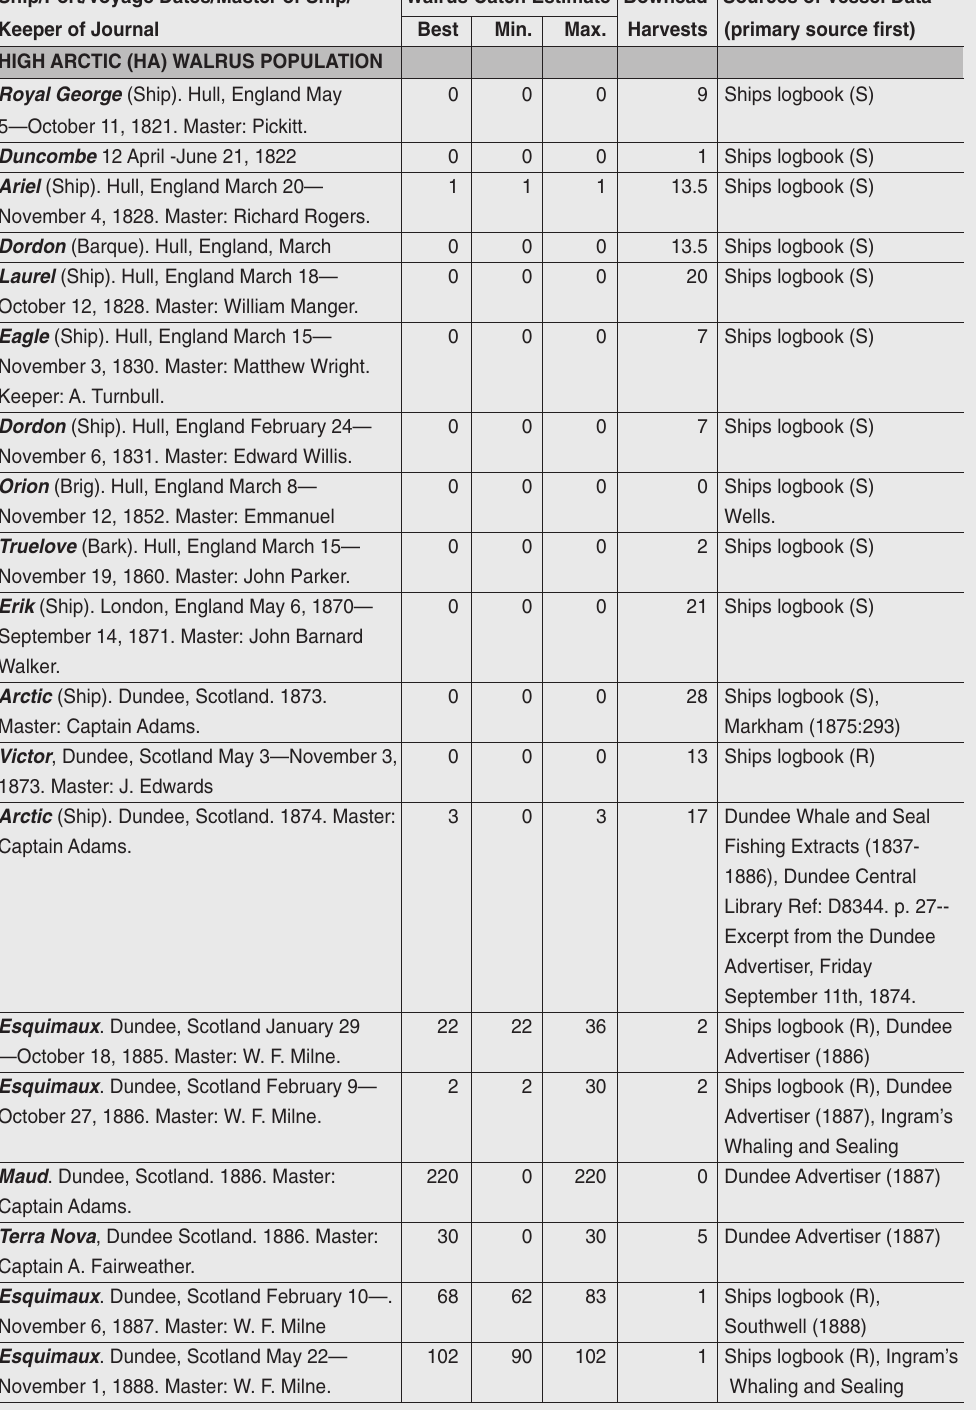
Table 3. Ship-based commercial catches of walruses and bowheads from the eastern Canadian Arctic (see below for explanatory